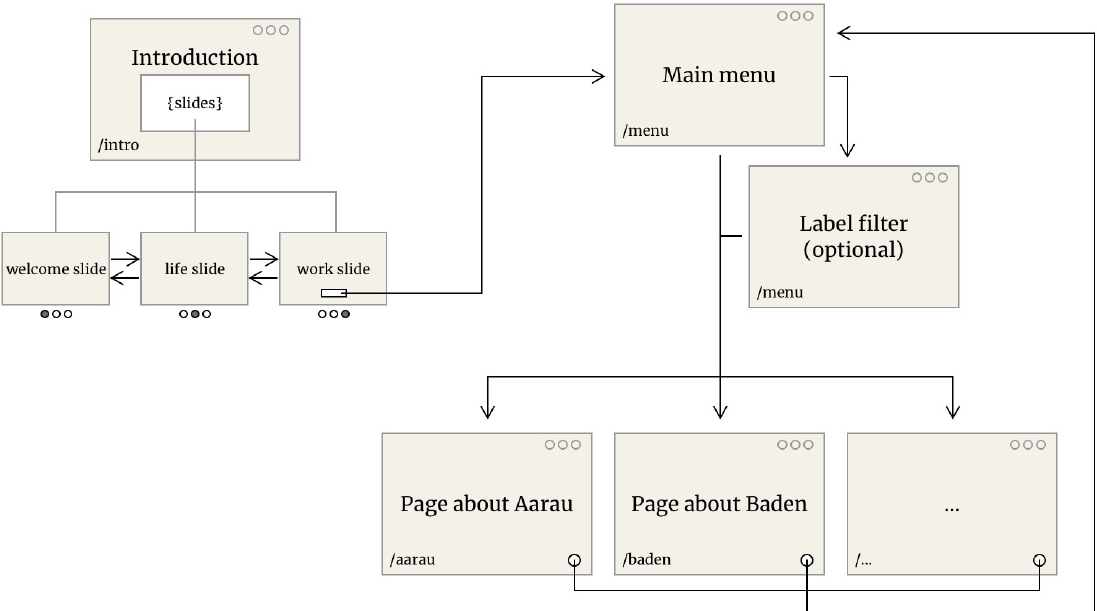
Figure 1. Flowchart of pages and page hierarchy. Aarau and Baden were chosen as pilot cities to test our